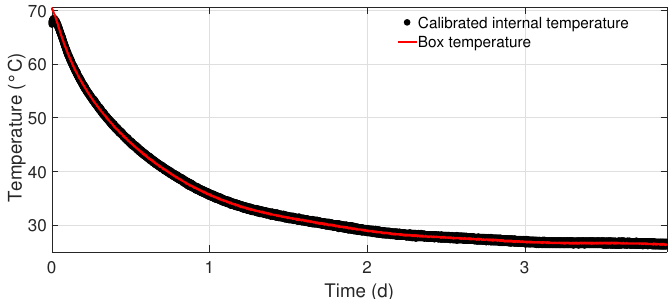
Figure 4. Temperature calibration curve of the internal temperature sensor for the LIS3MDL